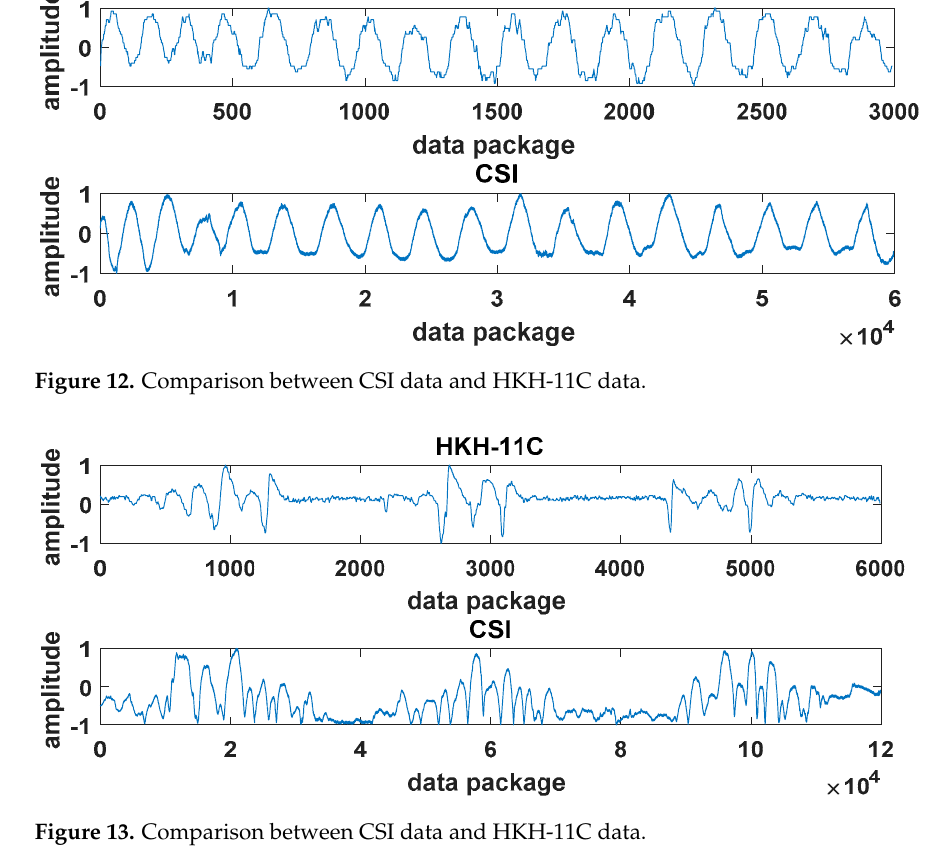
Figure 13. Comparison between CSI data and HKH-11C data.